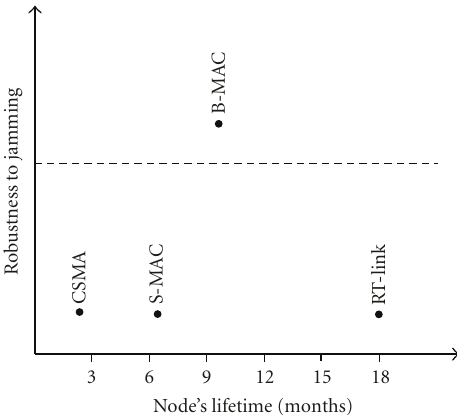
Figure 2: Comparison of robustness to jamming and energy- e ffi cient operation of sensor MAC protocols.